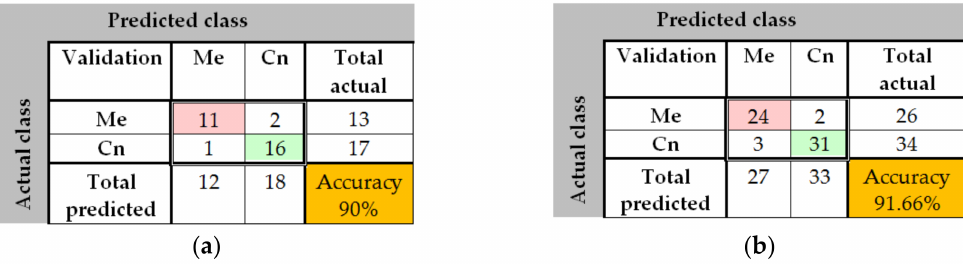
Figure 20. ( a ) Confusion matrix for validation phase in the case of GoogleNet pre-trained on Places365 for the PH 2 database; ( b ) Confusion matrix for validation phase in the case of GoogleNet pre-trained on Places365 for the ISIC 2019